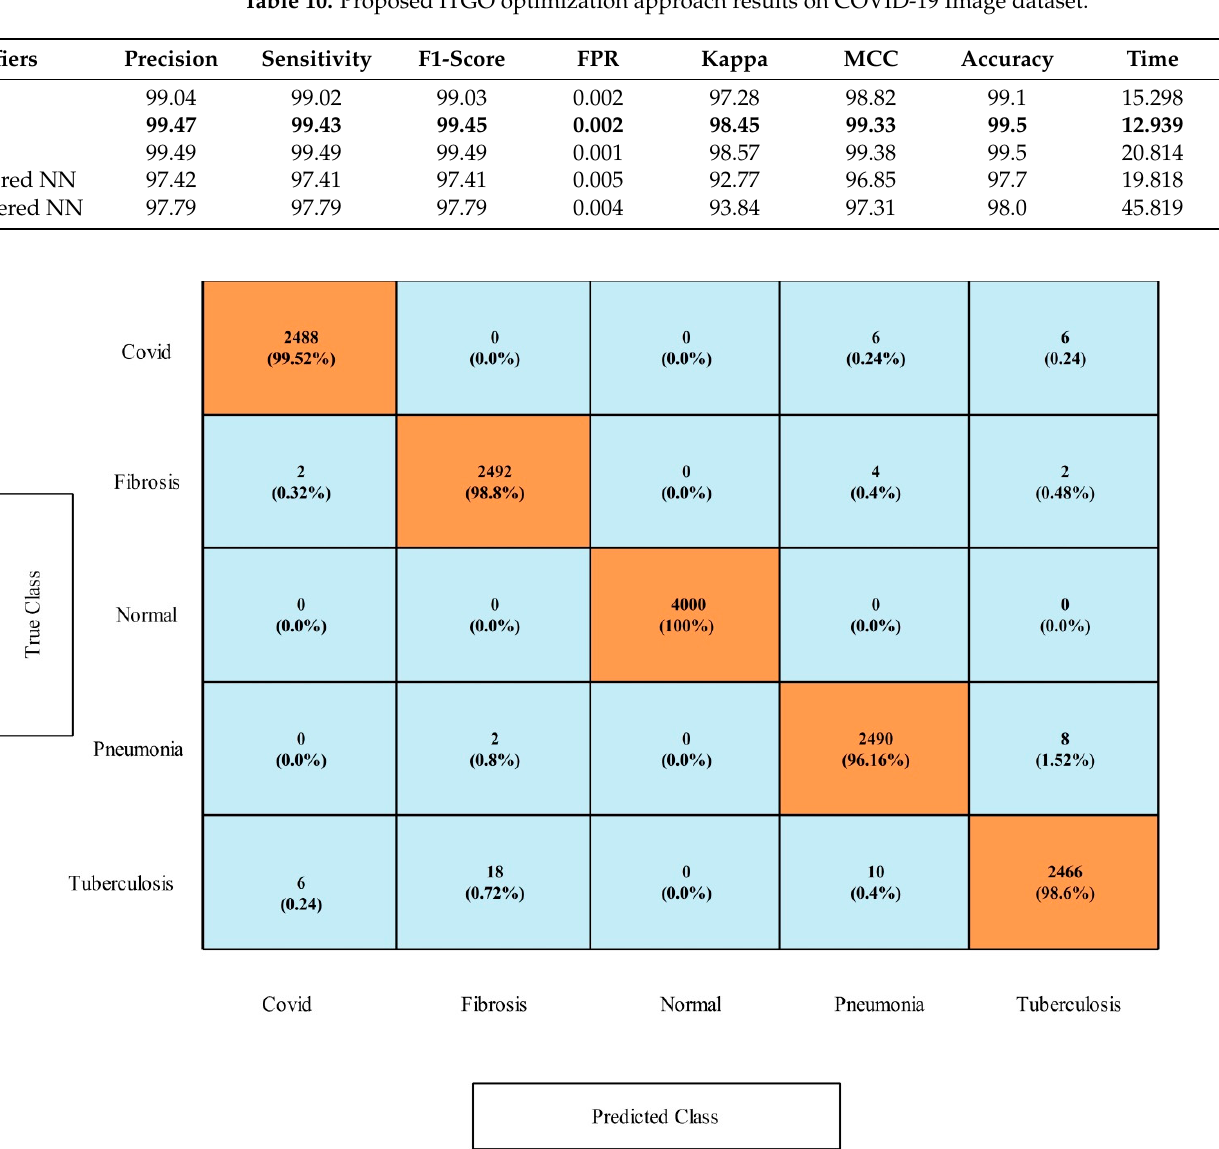
Table 10. Proposed ITGO optimization approach results on COVID-19 Image dataset.